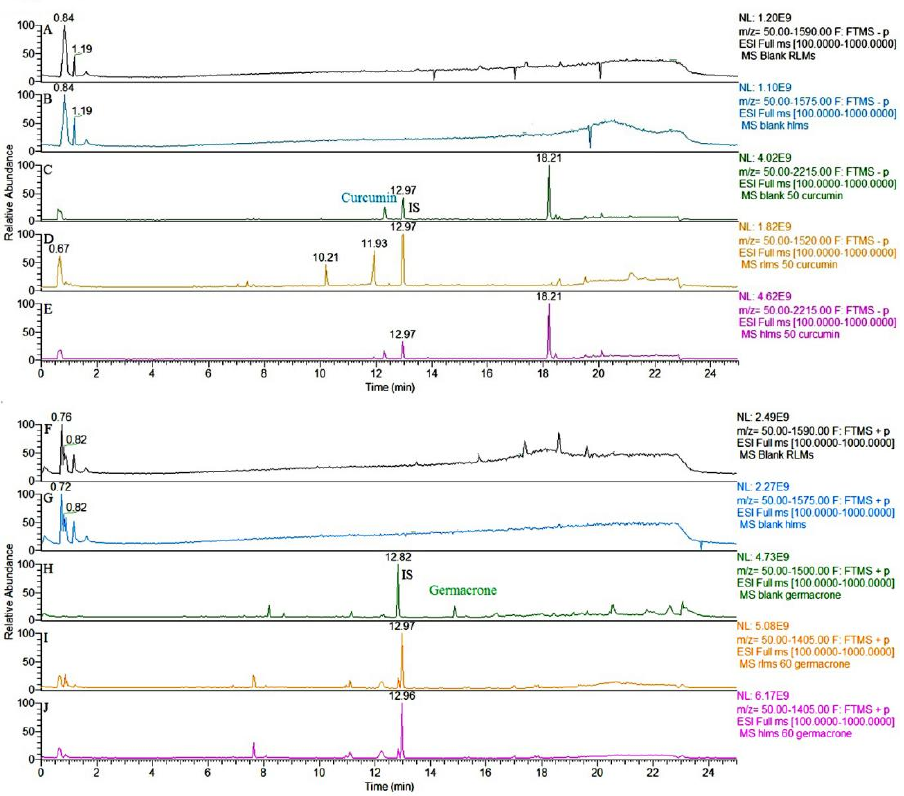
Figure 2. Representative HPLC–MS/MS chromatograms. A and F: blank RLMs; B and G: blank HLMs; C and H: standard curcumin and germacrone (50 and 60 μM); D and I: extract from RLMs with 50 μM curcumin and 60 μM germacrone after incubation for 120 min with NADPH; E and J: extract from HLMs with 50 μM curcumin and 60 μM germacrone after incubation for 120 min with NADPH.